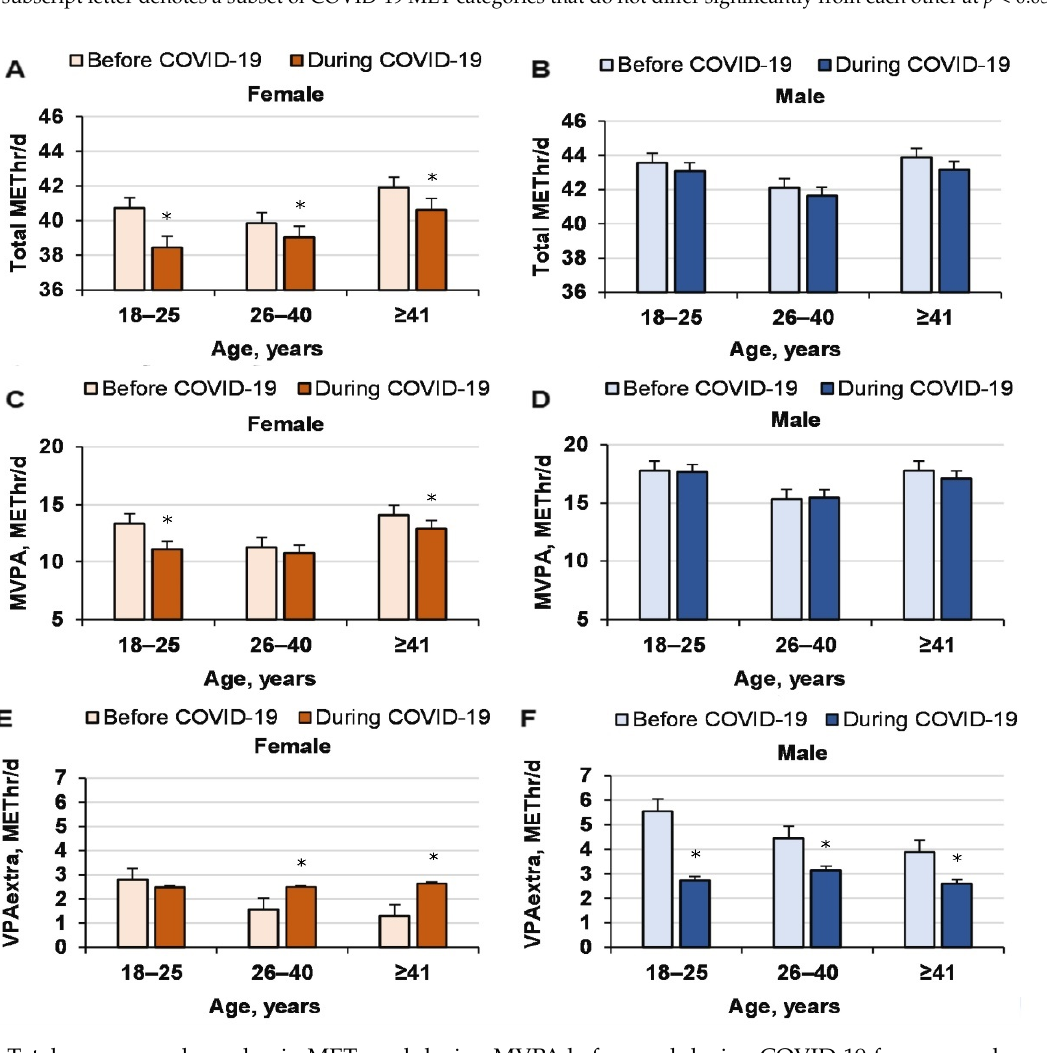
Figure 1. Total energy used per day in METs and during MVPA before and during COVID-19 for men and women of different ages. * compared to before COVID-19.